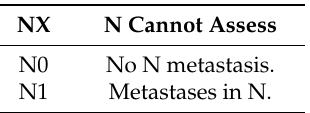
Table 3. Regional Lymph Nodes (N) in Renal Cell Carcinoma.